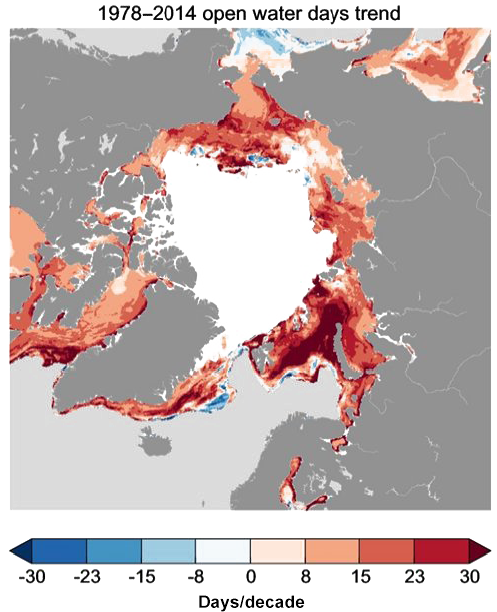
Figure 14. The linear trend in open water days in the Antarctic (1978–2014).